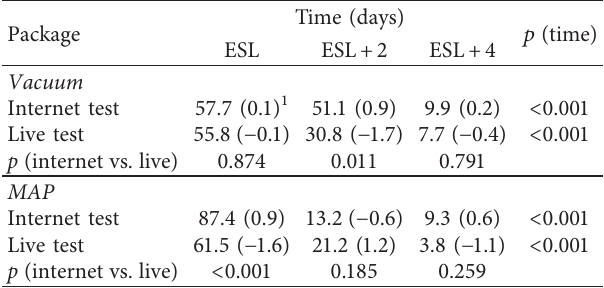
Results expressed as the percentage of consumers who expressed the in- tention calculated in the test group of the type (live or internet). 1 Stan- dardized